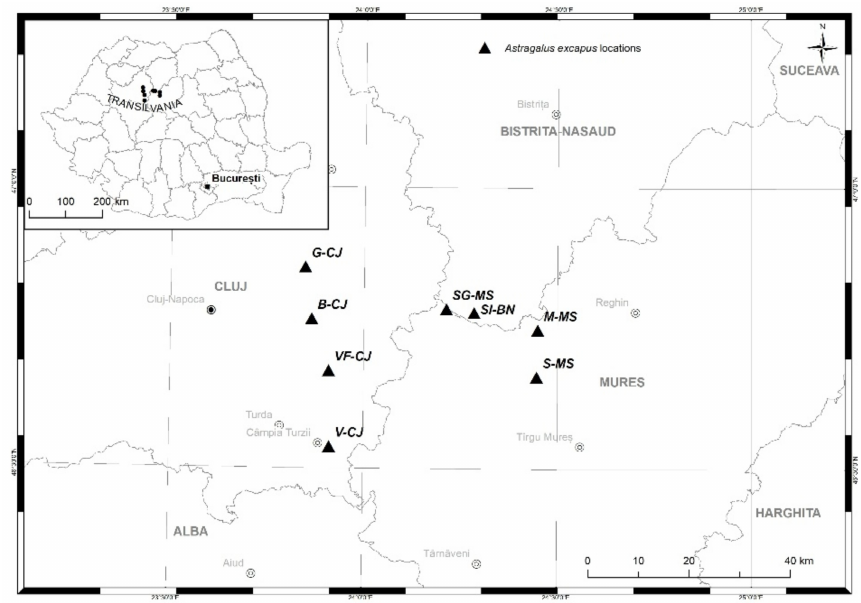
Figure 5. Map with the sites where samples of A. exscapus subsp. transsilvanicus were collected. B, Beleni population, Cojocna, Cluj County (CJ); V, Viis oara population; VF, Valea Florilor population; , G, G ă d ă lin population, Mures County (MS); M, Mil ă s el population; S, S ă bed population; SG, S ă rm ă s el , , , Gar ă population; SI, Silivas u de c â mpie population, Bistrit a N ă s ă ud County (BN). , , Eight populations were sampled in May 2014 representing the range of census size, area sizes, number of analyzed individuals, and geographical spread of the A. exscapus subspecies, as shown in Table 6. The geographical coordinates of the population sites were recorded using a global positioning system (GPS), and no specific permission was required for these locations. Table 6. Original information and number of A. exscapus subsp. transsilvanicus samples used in this study. Population.